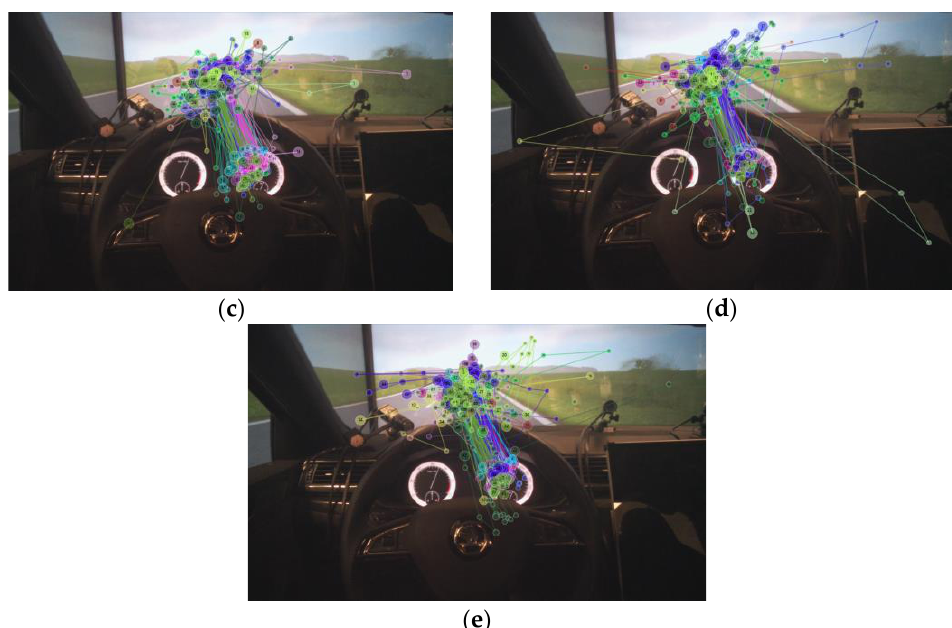
Figure 8. Eye tracker data analysis in the “Without signs” scenario. ( a ) The areas of interest (AOI) map consisting of the “Track” area highlighted in yellow and the “Dashboard” area in green. ( b ) The total share of time of gaze focus on the different AOIs under different motion conditions. ( c – e ) are the “Gaze Maps”, respectively, under “No Motion”, “Mild Motion”, and “Full Motion” conditions.